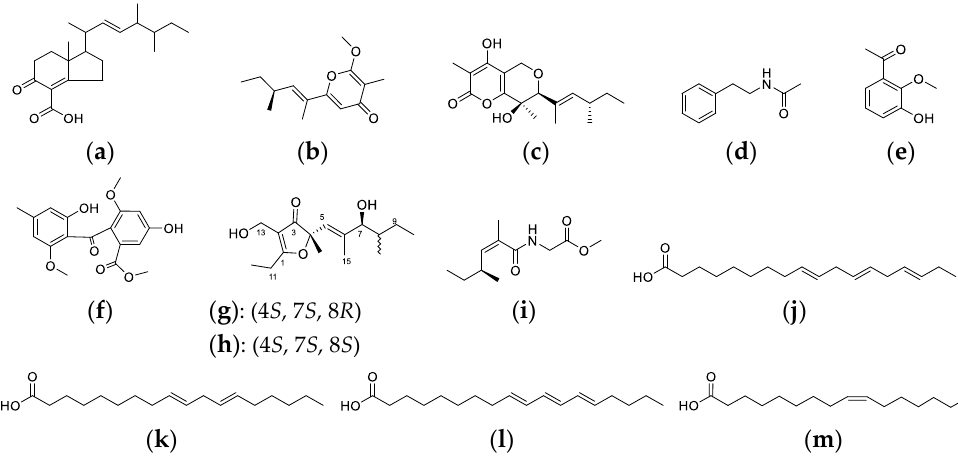
Figure 7. Thirteen secondary metabolites ( a – m ) previously discovered from strain R1.